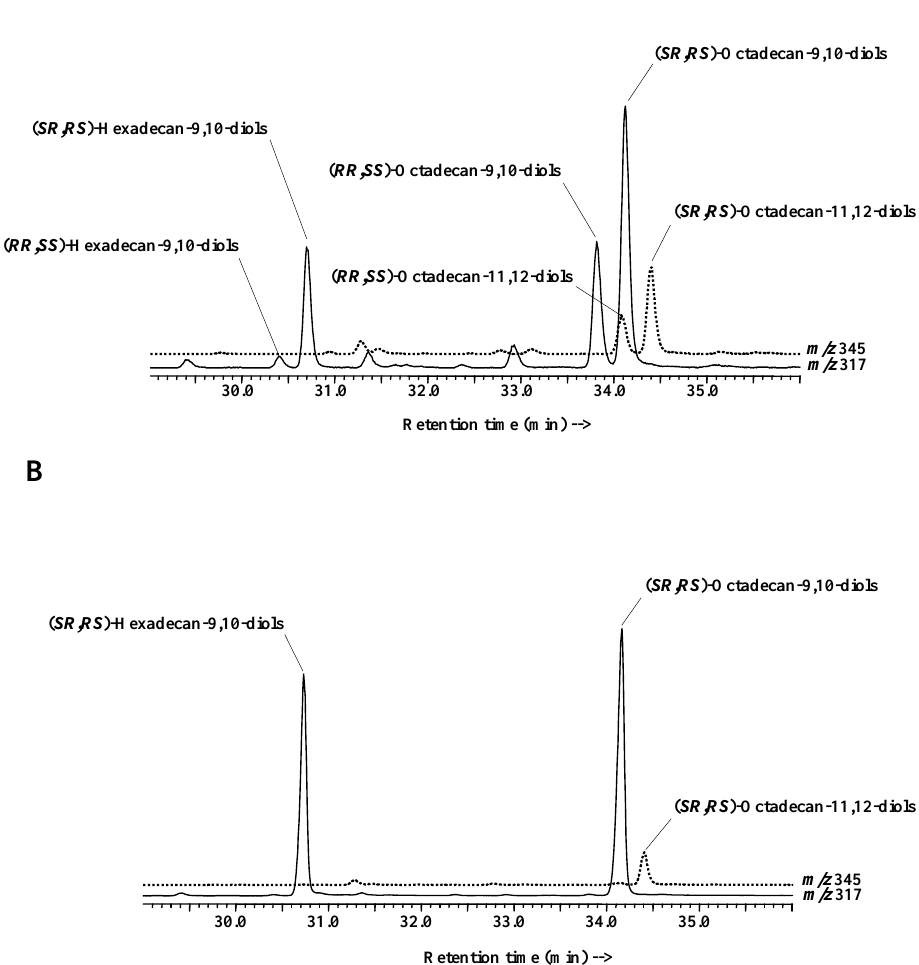
Fig. 10. Partial m/z 317 and 345 ion chromatograms showing the distribution of silylated OsO 4 derivatives of cis and trans monounsaturated fatty acids in surface sediments (0–1cm) collected at the stations 110 (A) and 260 (B)